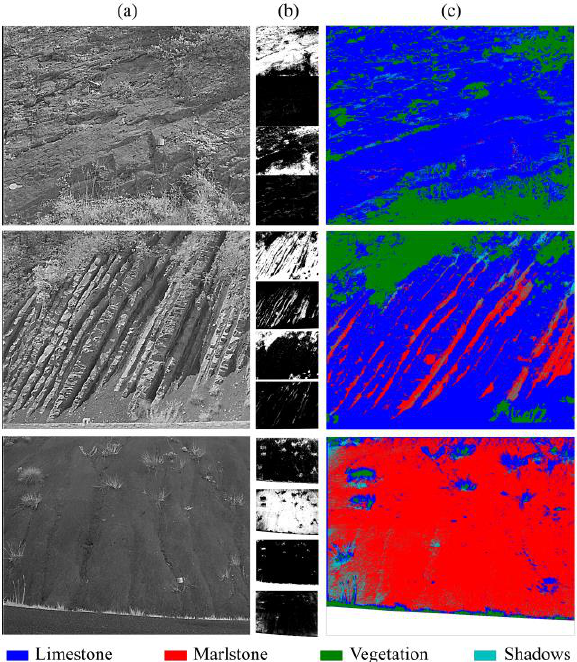
Figure 5. (a) Band 5 of the Mini-MCA6 in reflectance values, (b) images of probability and (c) the final rock classification map Figure 6. Moisture classification map. Combination of (Del Pozo et al., 2015)